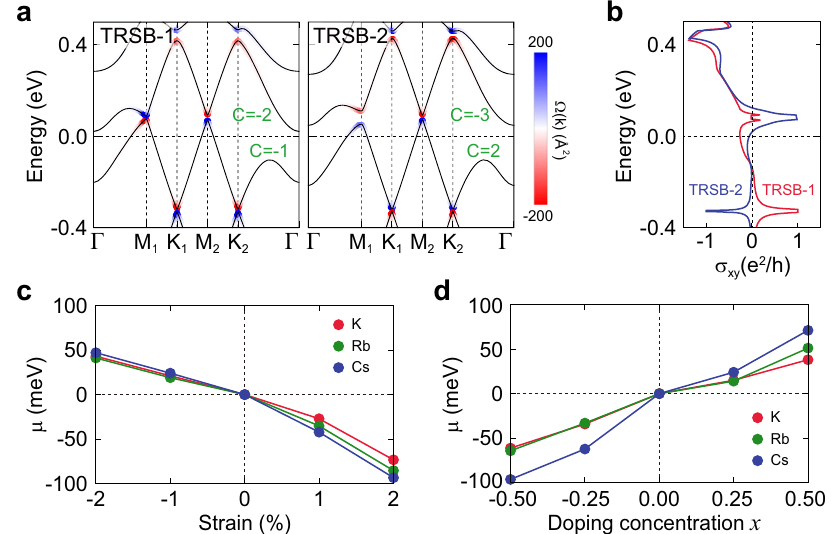
c DFT calculations of the chemical potential μ as a function of an uniform biaxial strainin A V 3 Sb 5 for A =K,Rb,andCs. d DFTcalculationsofthechemicalpotential μ as a function of doping concentration x for A 1+ x V 3 Sb 5 . The detailed DFT band structuresunderthebiaxialstrainandalkalidopingareprovidedinSupplementary Note